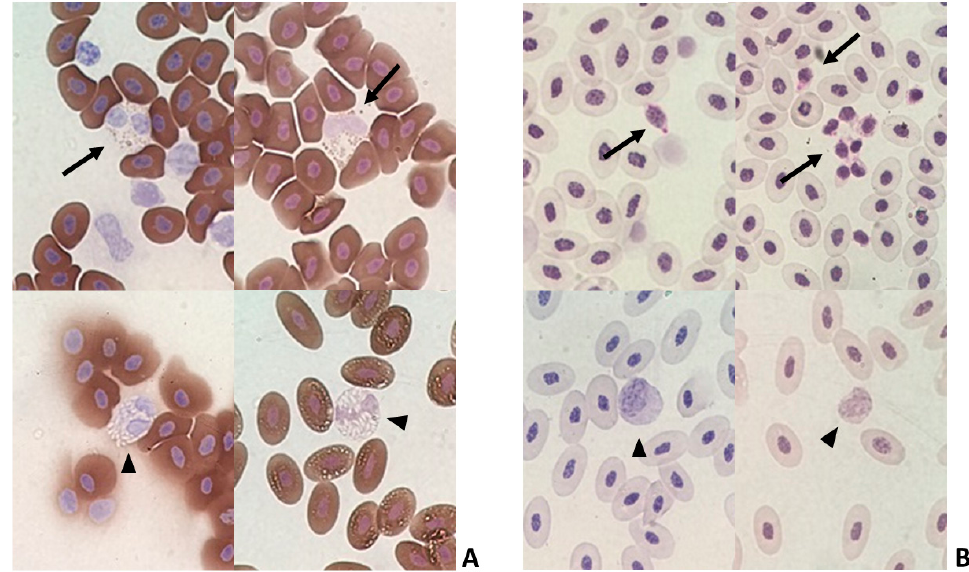
Figure 6. Blood smear slides stained by cytochemical methods. ( A ) Sudan Black B (SBB) positive eosinophils (arrow) and SBB negative heterophils (arrowhead). ( B ) Periodic Acid Schiff (PAS) positive thrombocytes (arrow) and PAS negative lymphocytes (arrowhead).